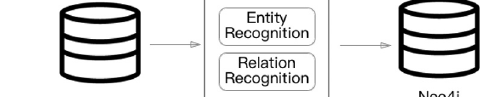
Figure 4. Data extraction from